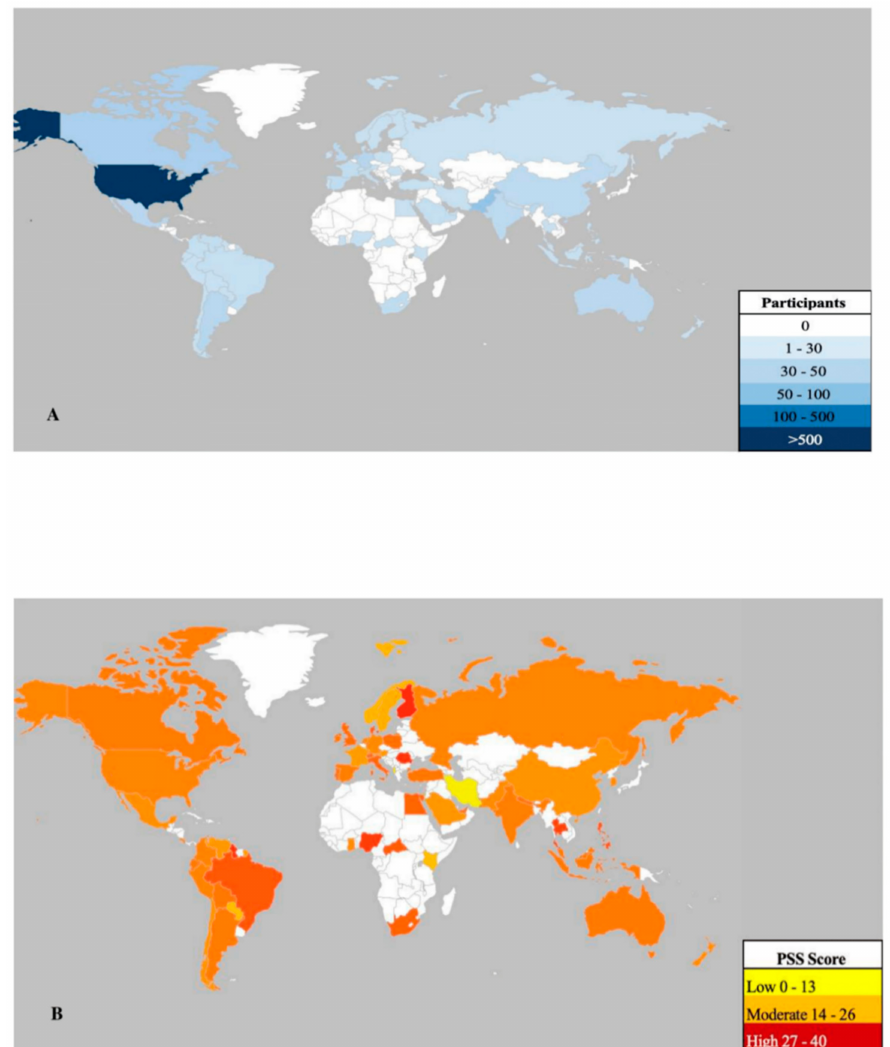
Figure 3. Worldwide representation of perceived stress levels as measured by the Perceived Stress Scale (PSS-10). ( A ) represents number of respondents in the survey in countries including: Albania,